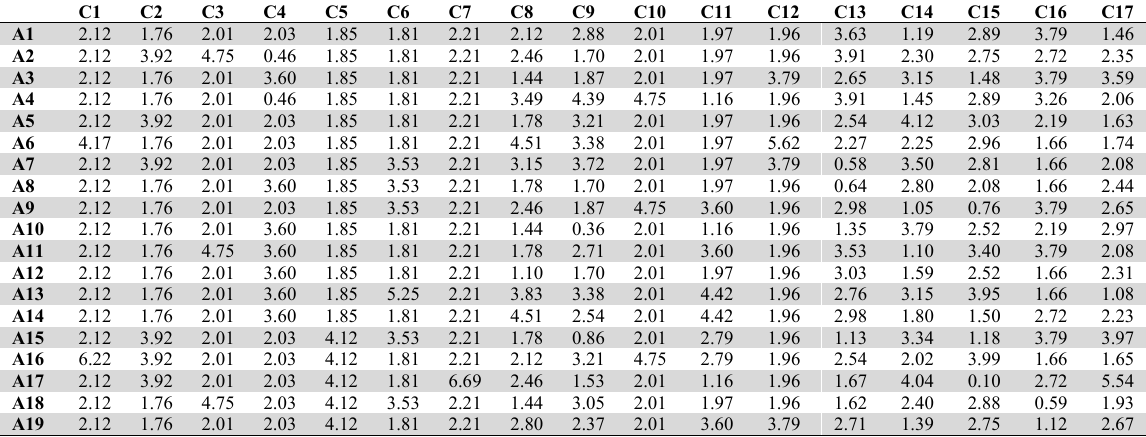
The Decision Matrix